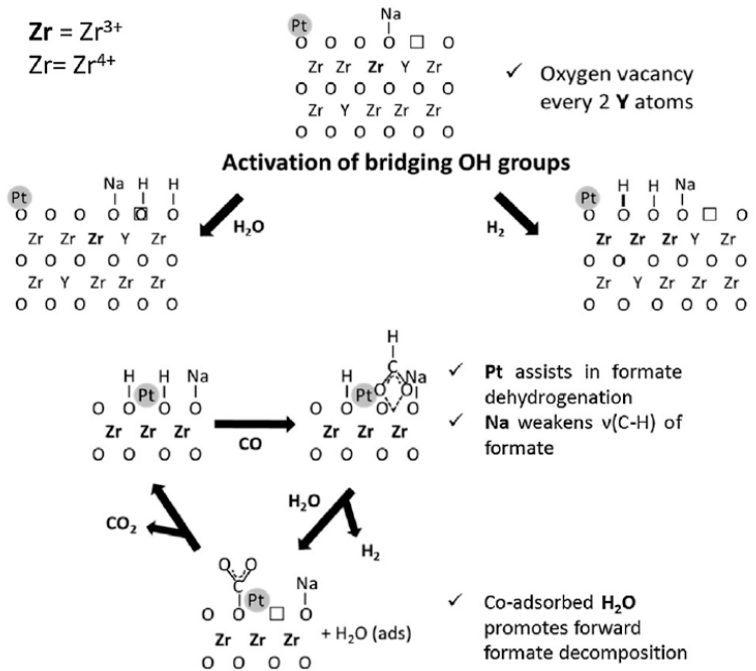
Figure 21. LT WGS mechanism proposed by Martinelli et al. on Na doped Pt / YSZ catalysts, reproduced from [146], with permission from Elsevier, 2017.